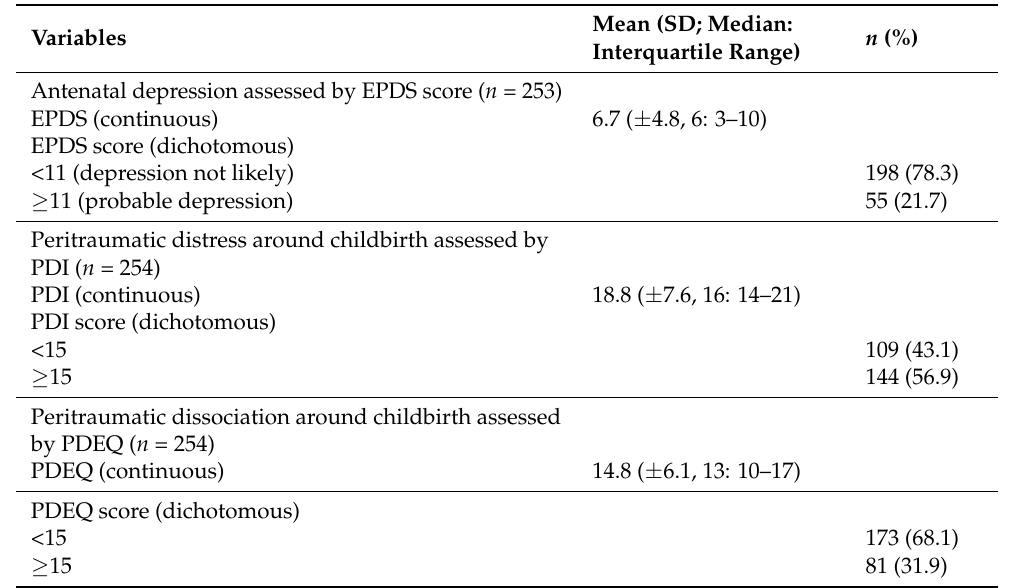
Table 3. Mental health state during pregnancy and peripartum ( n = 254).